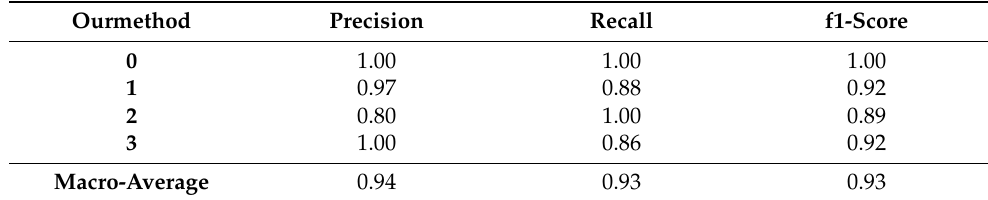
Table 12. Performance of Our